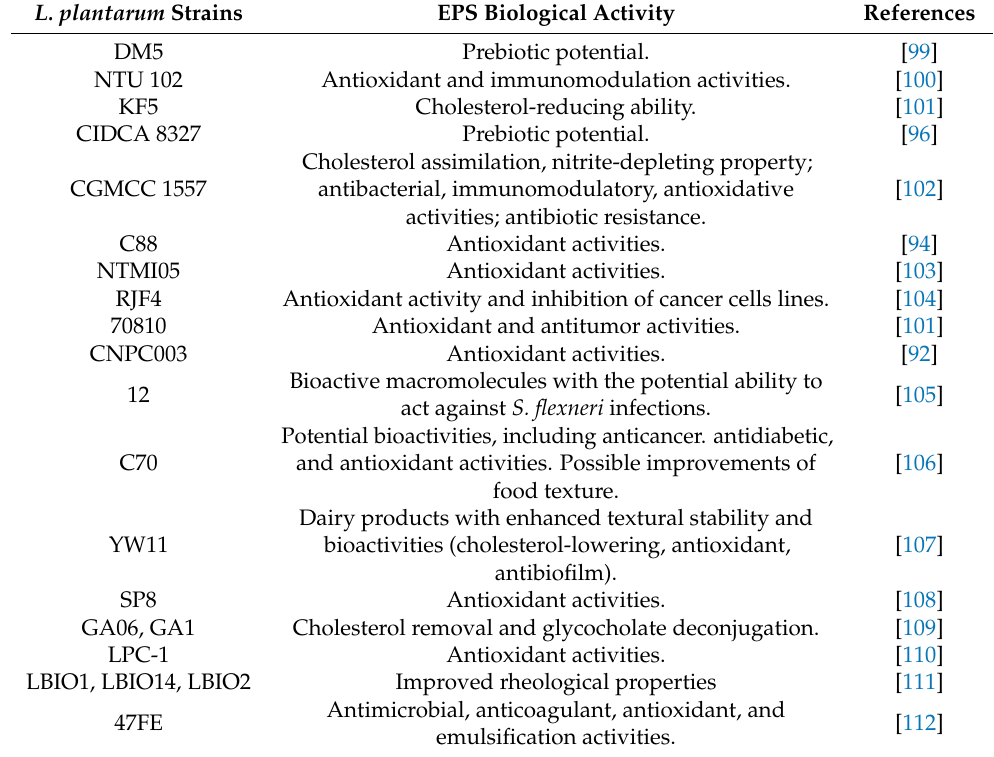
Table 3. Various L. plantarum strains producing EPS with respective biological